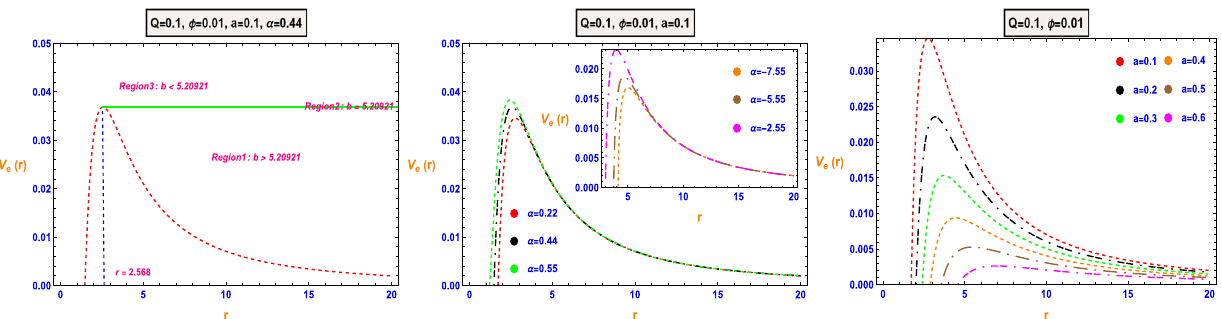
Fig. 1 The behavior of V e ( r ) versus r for some specific values of model parameters (left panel), for different α (middle panel) and for different a (right panel) with M = 1. In the left panel, dashed blue line indicates the radius of photon sphere r p while green line corresponds to V e ( r ) = 1 / b 2 c